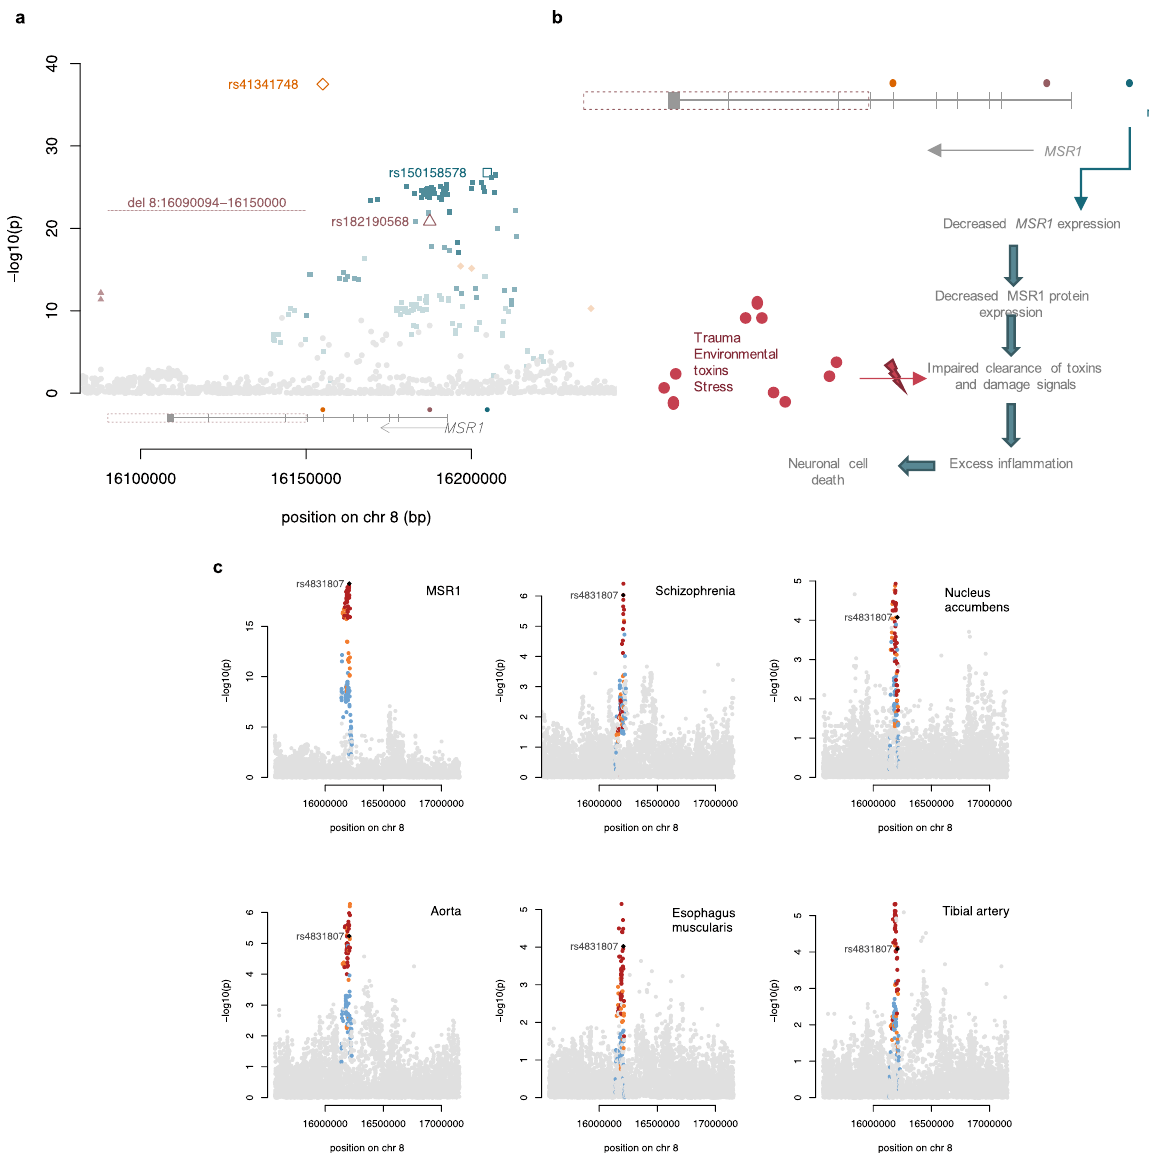
Fig. 5 Serum MSR1 is causally associated with schizophrenia. a Genetic architecture of serum MSR1. Each of the three independent variants and their LD variants are represented in orange, teal, and purple, respectively; the intensity of the colours indicates the strength of linkage disequilibrium ( r 2 ). A rare deletion is also indicated in purple, and is in complete LD with the independent variant rs182190568. Below the signal plot, the location of the variants respective to the gene are indicated using coloured points for the SNVs and a dotted box for the deletion. b Proposed mechanism of how decreased MSR1 may lead to neuronal damage, resulting in neuropsychiatric disease. c Association signal plots at the MSR1 locus for (clockwise) serum MSR1, schizophrenia, gene expression of MSR1 in nucleus accumbens tissue, aorta, oesophagus muscularis and tibial artery. The lead pQTL variant is denoted by a black diamond, while variants in LD are coloured according to the strength of LD with the lead variant (red [ r 2 > 0.8]; orange [0.5 < r 2 > 0.8]; blue [0.2< r 2 > 0.5]; grey [ r 2 <